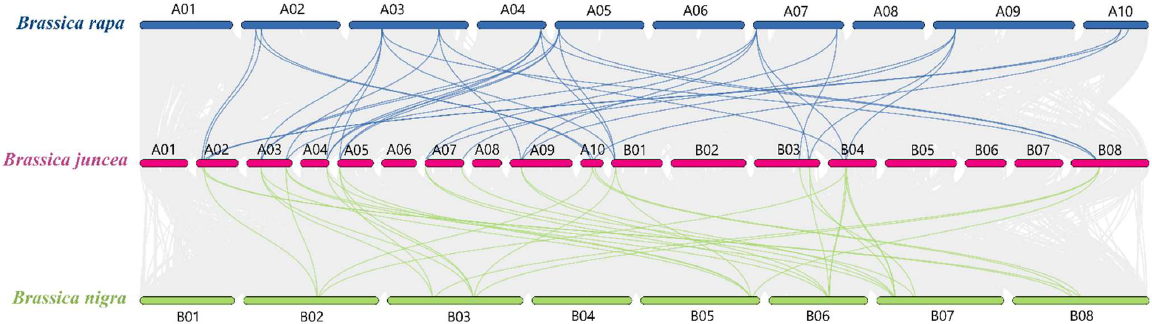
Figure 4. Collinearity analysis of CKX gene families in B. rapa , B. juncea , and B. nigra . The colored round rectangles represent the chromosomes of three cruciferous plants. The gray curves connect protein-coding genes in the synteny blocks, and the blue and green curves represent gene pairs that are collinear with UBC genes in B. juncea / B. rapa and B. juncea / B. nigra , respectively.